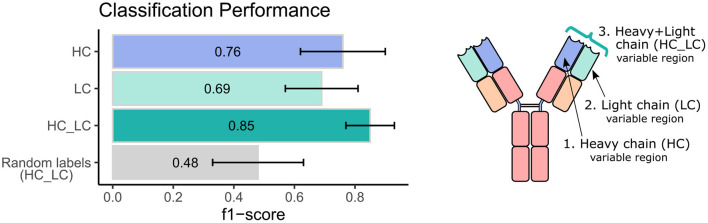
Classification performance of the ML model using heavy and light chain variable region repertoires. Bar graphs show the average F1 score ± standard deviation (black line) across a 1,000 iterations. Light blue bar indicates the result using the heavy chain (HC) dataset, turquoise bar for the light chain dataset, green bar for the integrated heavy and light chain (HC_LC) dataset, and gray bar for control analysis using the HC_LC dataset with random labels.